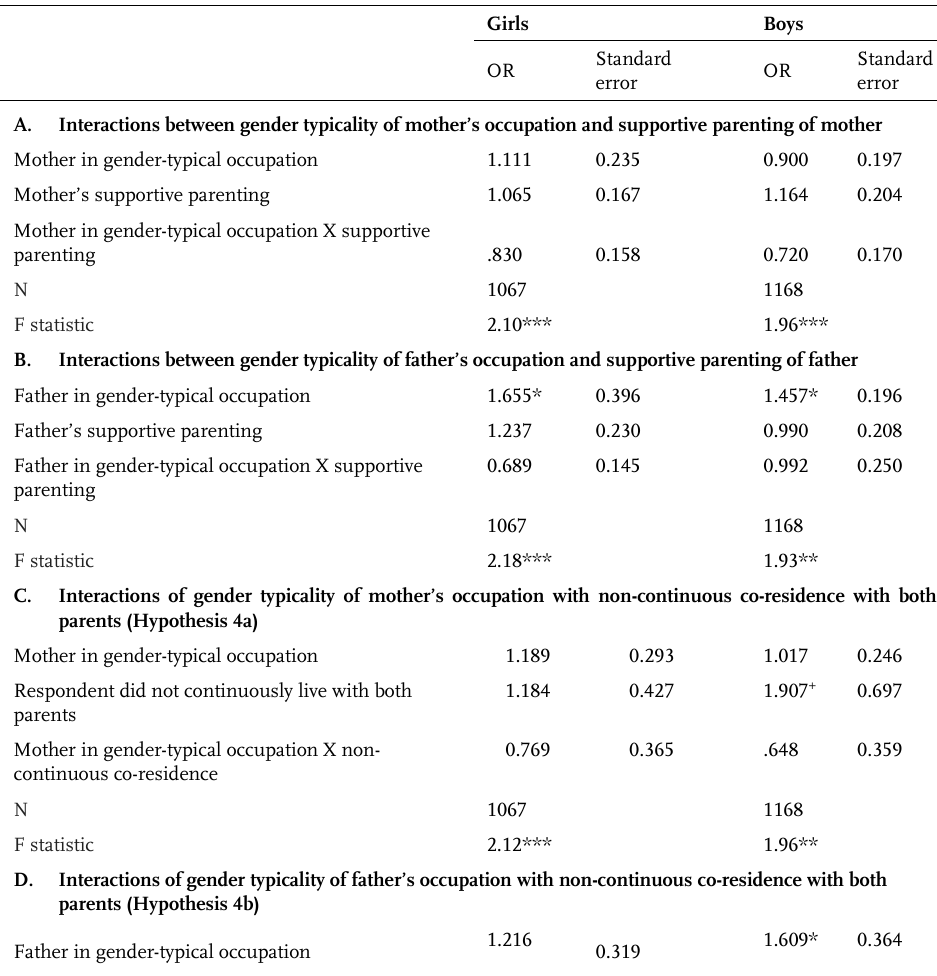
Table 3 : Interactions between gender typicality of mother’s and father’s occupation and supportive parenting (Panel A and B) and co-residence with both parents (Panel C and D), respectively